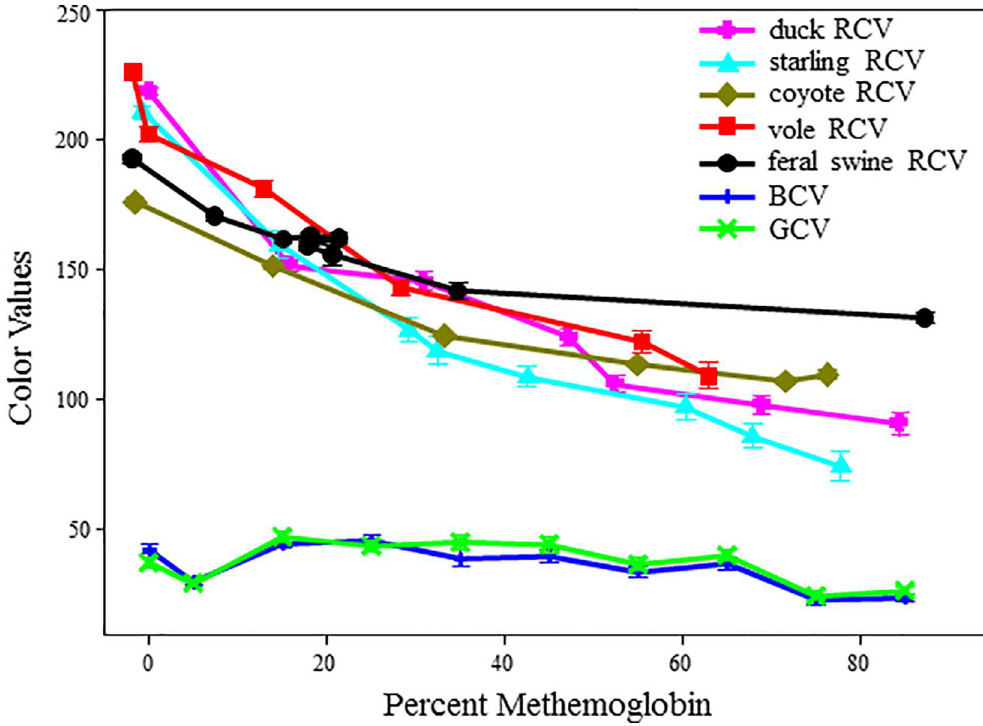
Fig 3. Red color value variation with increasing methemoglobin levels. Blood samples were treated with sodium nitrite or PBS, spotted onto Whatman filter paper, and scannedwith a flatbed scanner. Scannedimages were analyzedwith ImageJ software to generate RCV, GCV, and BCV. The RCV data presentedrepresents the averageof 3 (mammal), 4 (duck), or 9 (starling) different scannedimages and the error bars correspond to the standarderrors of the means. GCV and BCV data representsan averageof all 19 blood spot images from all species. doi:10.1371/journal.pone.0167942.g003 color values were measured in all the blood samples, but only the red color value had predictive power for estimating percent methemoglobin. All the animals showed comparable RCV at similar methemoglobin levels, except the coyote and feral swine at 0% methemoglobin (Fig 3). Table 1. Comparative analysis of the spectrophotometric and colorimetric predicted percent methemoglobin levels. Species General Model Individual Model All Species Average Eastern European Starling Mallard